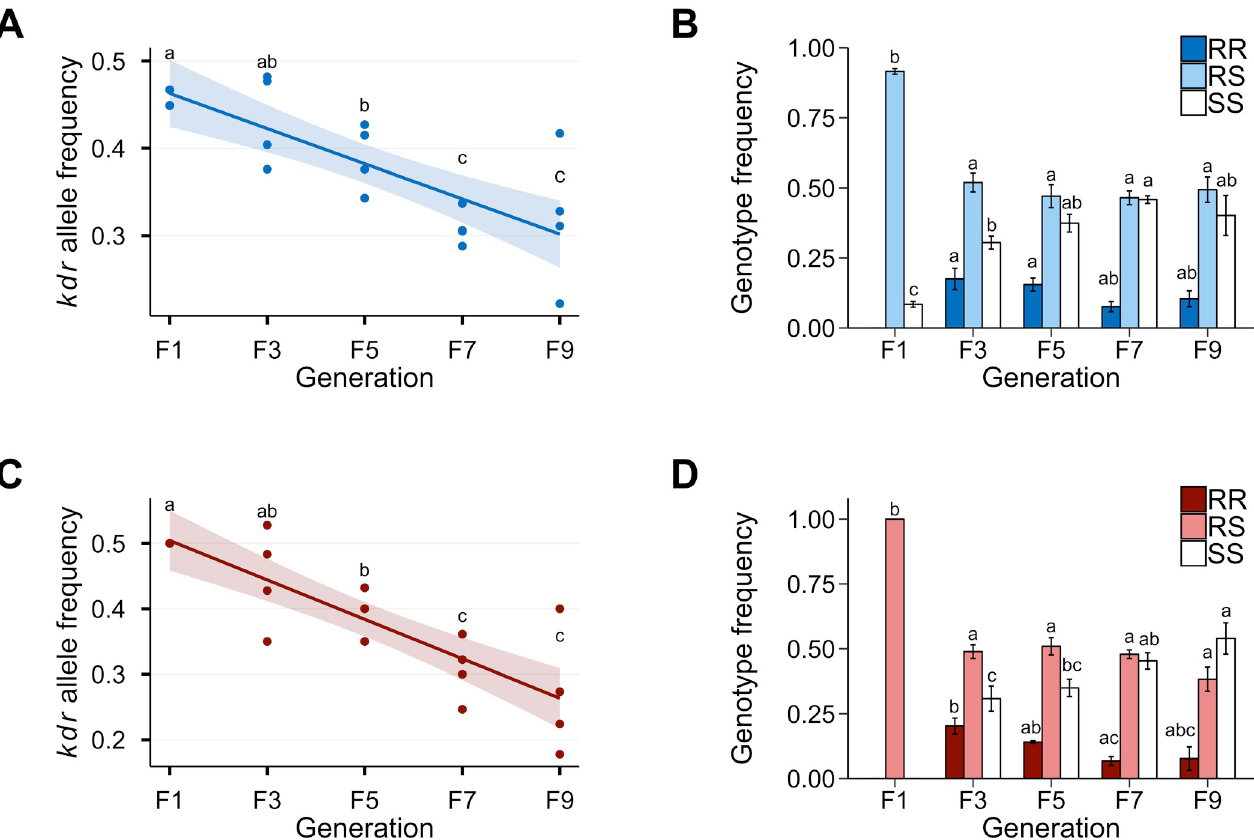
Fig 2. Allele-competition results for the KR (A and B) and CKR (C and D) experiments. Frequency of the kdr allele was significantly reduced from generation F 1 to F 9 for both KR (A) and CKR (C). The SS genotype (homozygous susceptible, white bars) increased significantly from generation F 3 to F 7 for both KR (B) and CKR (D), but was not significantly different from F 3 to F 9 for the KR experiment (B). The RR genotype changed significantly from F 3 to F 7 in the CKR experiment (B), but there was no significant difference in the KR experiment (D). Frequency of heterozygotes (RS) did not change between generations. Different letters represent significant differences (p < 0.05) of the susceptible and kdr alleles (A and C) or the SS, RS, and RR genotypes (B and D) across generations only. Shaded area around the line represent 95% CI (A and C) and bars represent the standard error (B and D).